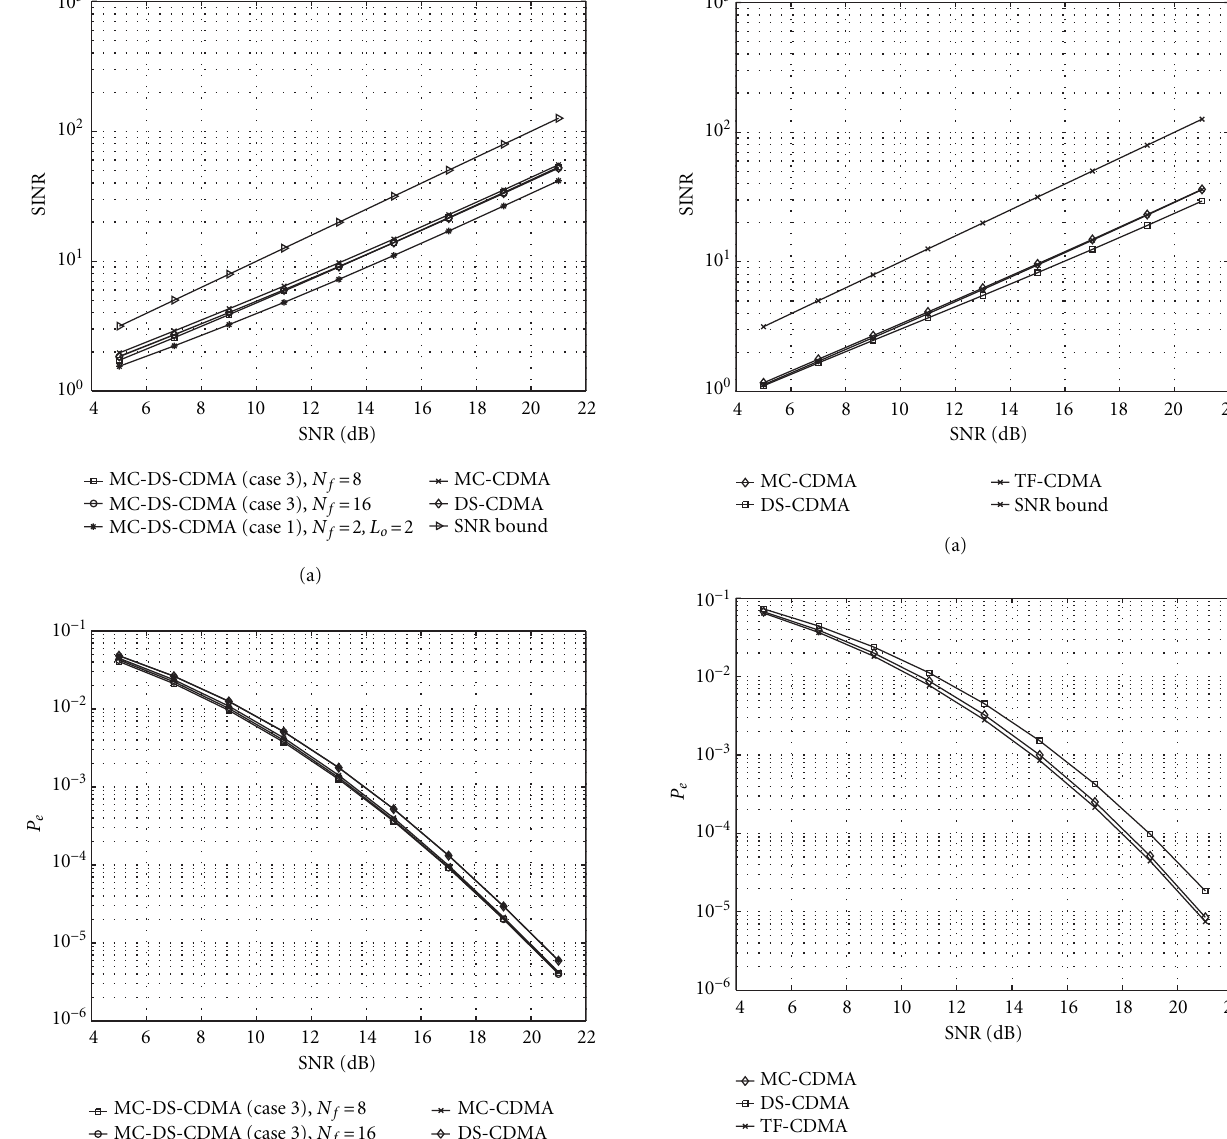
still remain in an MC-DS-CDMA system. Again, the perfor- mance of the three systems is virtually identical.